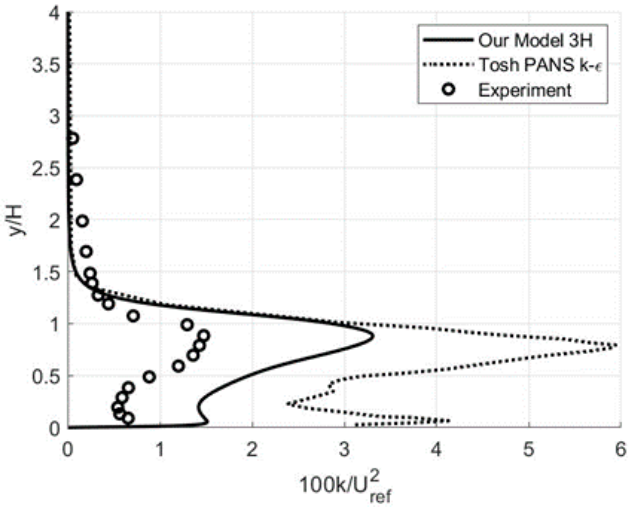
Figure 8. Mean kinetic energy profiles at x / H = 2 from the step ( 𝑓 (cid:3084) = 0.667, 𝑓 (cid:3038) = 0.2).